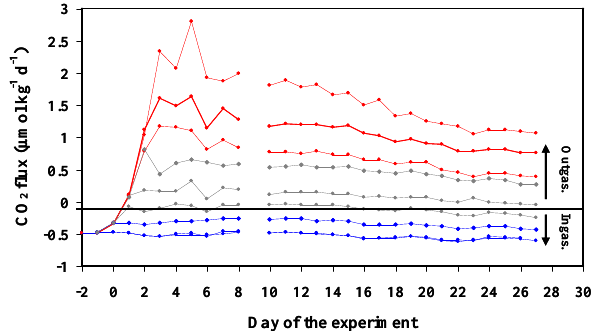
Fig. 3. Daily CO 2 fluxes for all CO 2 treatments over time. High Daily CO 2 fluxes for all CO 2 treatments over time. High CO 2 treatments are shown in red, 825 CO 2 treatments are shown in red, medium in gray and low CO 2 are medium in gray and low CO 2 are blue. Estimates include chemical enhancement according to 826 blue. Estimates include chemical enhancement according to Hover Hover and Berkshire (1969). 827 and Berkshire